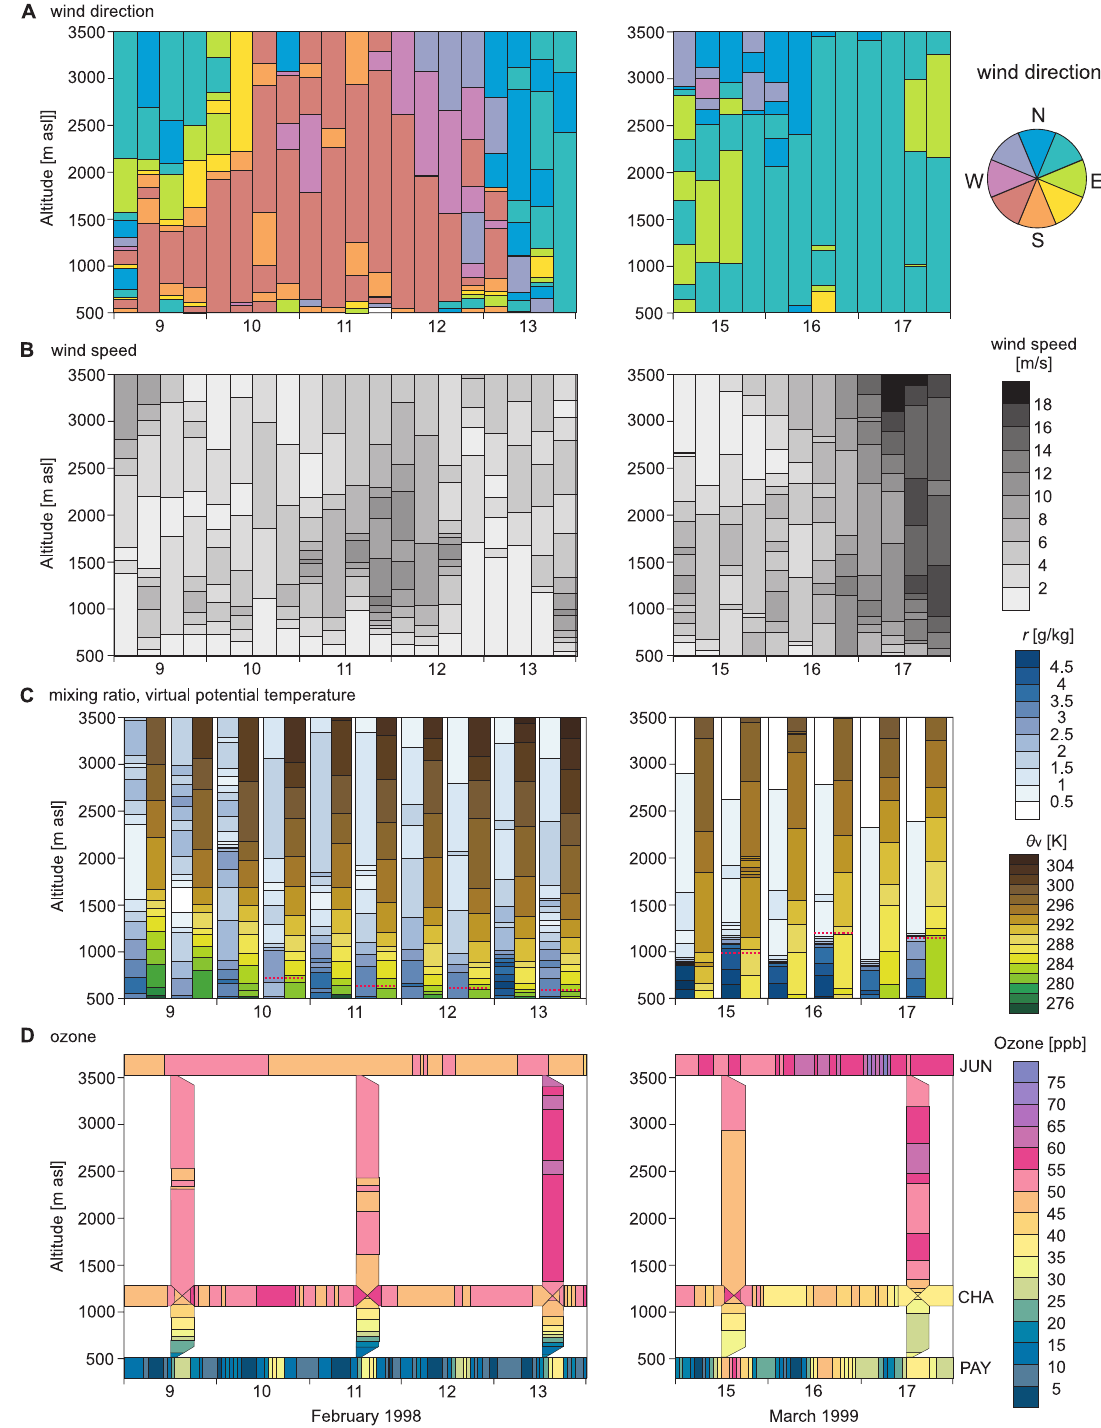
Fig. 4. Time-height cross sections of (a) wind direction, (b) wind speed, (c) water vapour mixing ratio (left bars) and virtual potential temperature (right bars) and (d) ozone concentrations. Left panels: February 1998 campaign, right panels: March 1999 campaign. The plots show measured data from aerological soundings from Payerne which were supplemented with hourly averaged station measurements of ozone concentration. No interpolation was done. Data were plotted as raw data and every measurement point was attributed to half of the layers above and below the measurement altitudes except for wind (layer below). Note that wind soundings were performed every 6 hours (00, 06, 12, 18 UTC), full meteorological soundings every 12 hours (00, 12 UTC) and ozone soundings every two days (12 UTC). The red solid lines in panels (c) give the estimated mixing